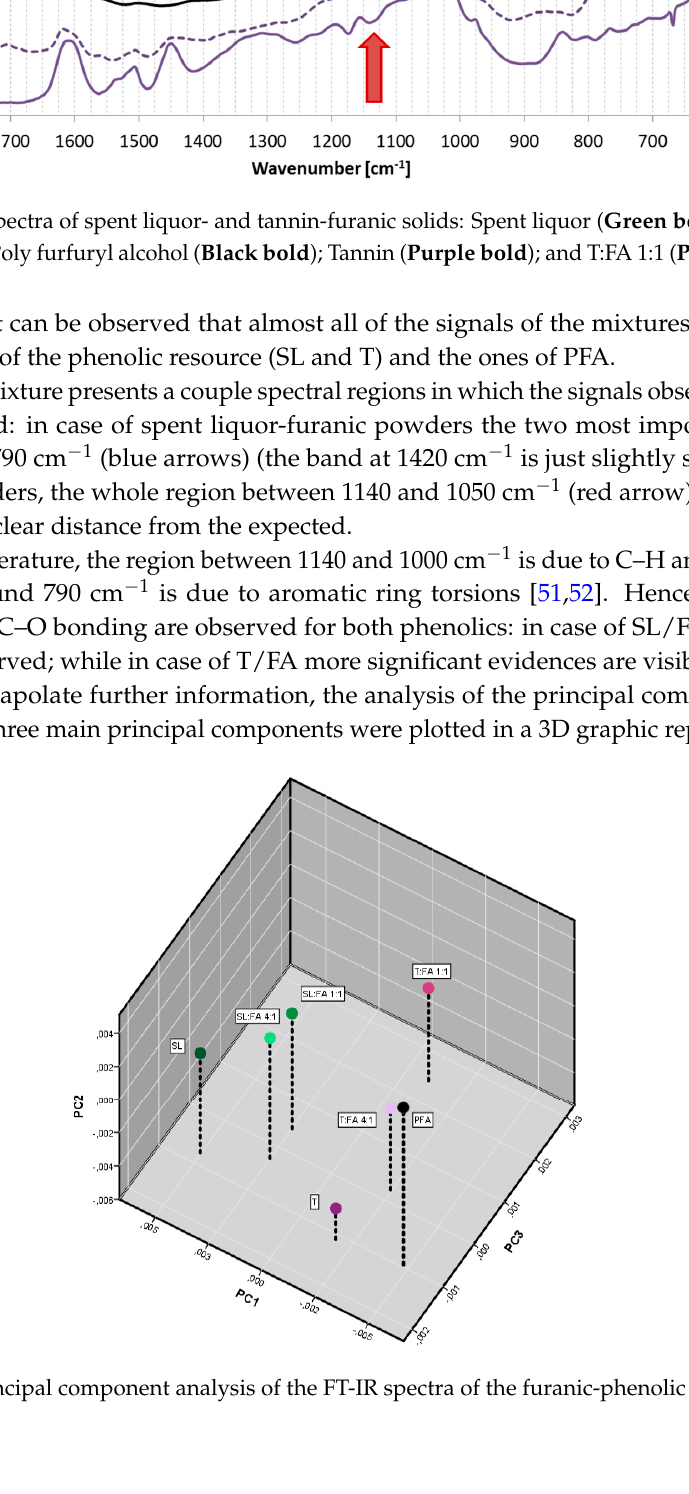
Figure 6. Principal component analysis of the FT-IR spectra of the furanic-phenolic